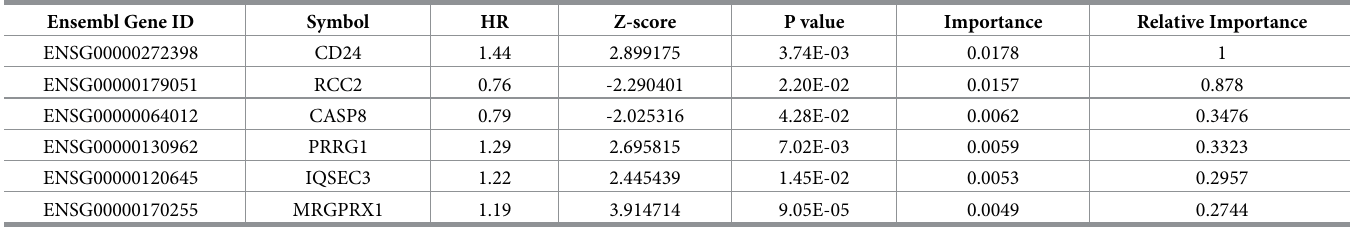
Table 2. The 6 genes were significantly associated with the overall survival in the training-set patients. Ensembl Gene